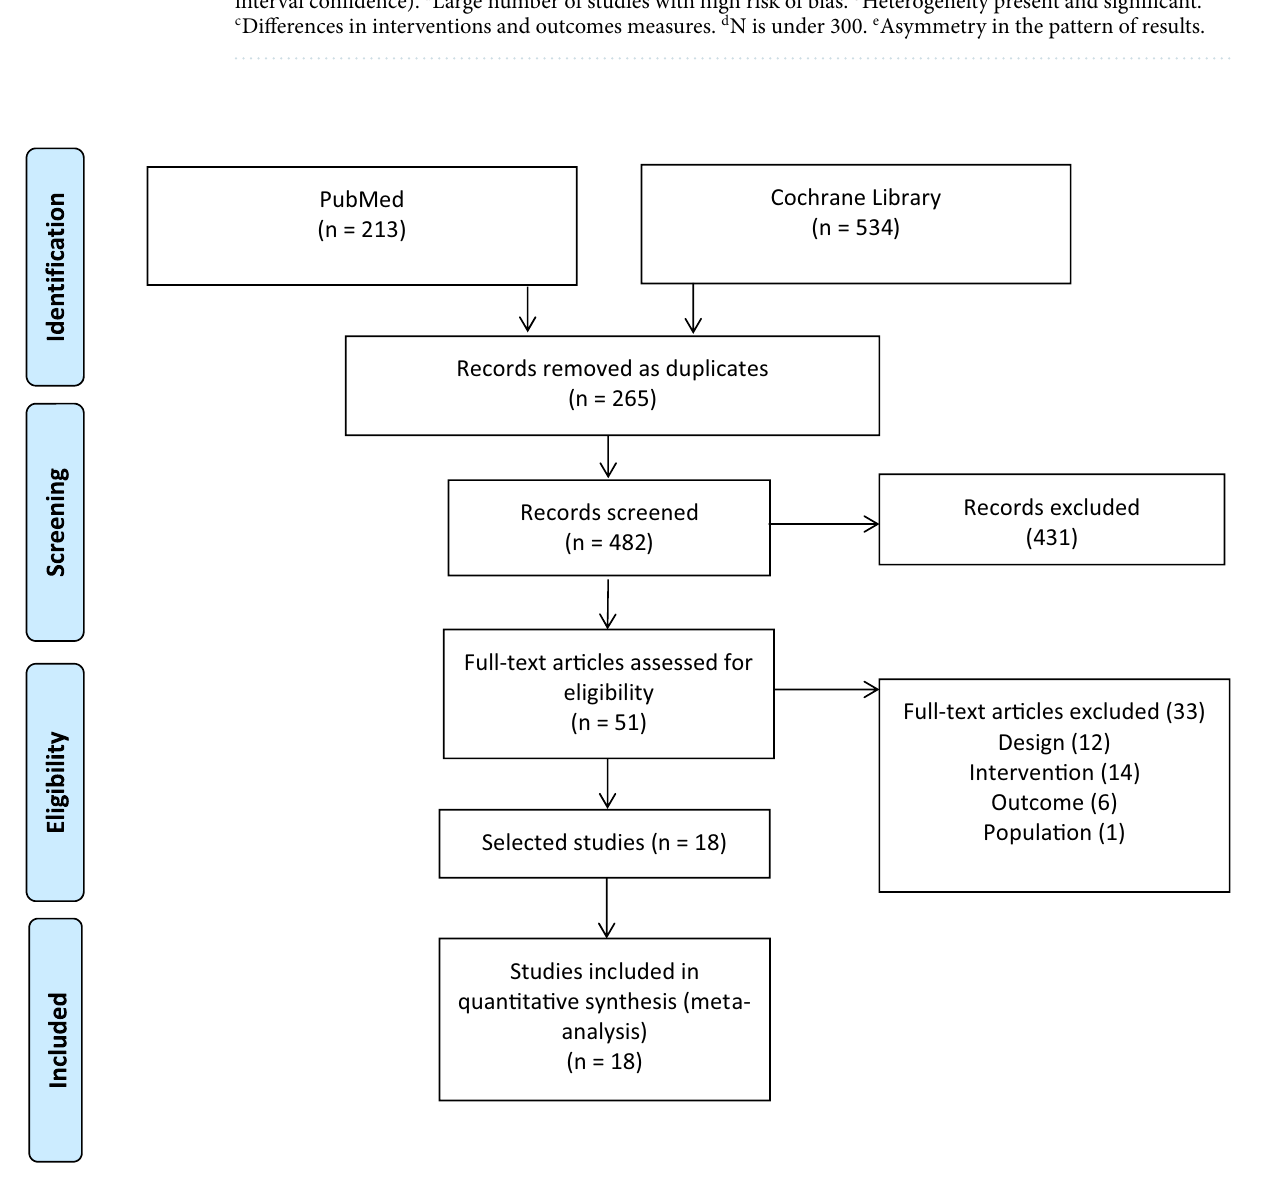
Figure 1. PRISMA flowchart of article